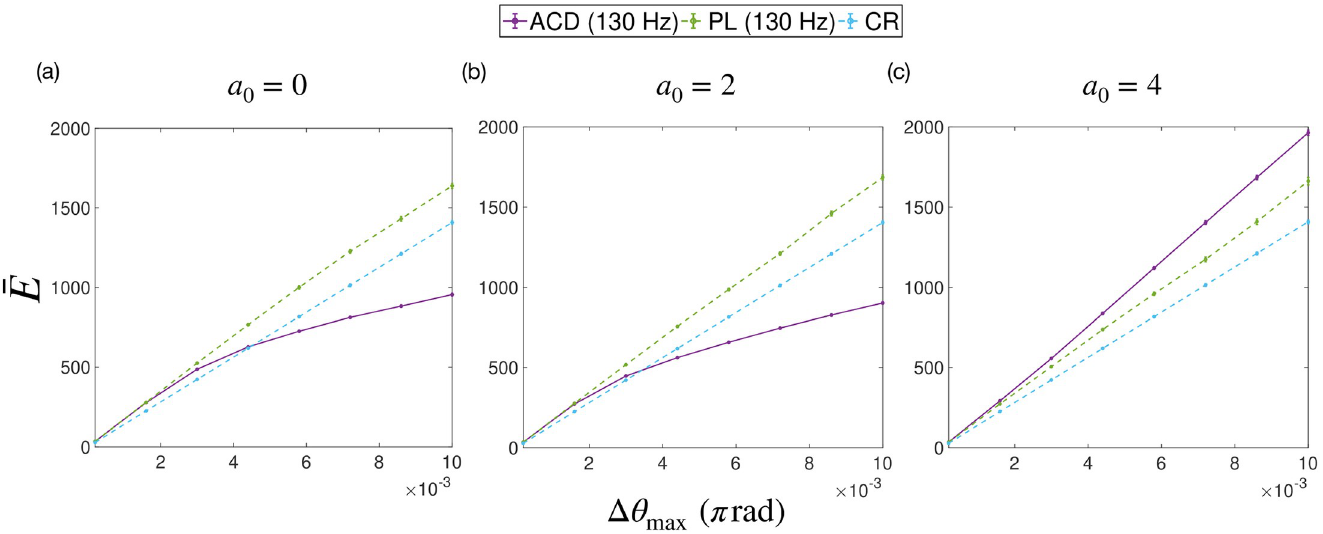
Fig 8. The total energy used by different stimulation strategies, when applied to a simulated system, as a function of the stimulation intensity Δ θ max . The strategies tested were: adaptive coordinated desynchronisation (ACD), phase-locked (PL) and coordinated reset (CR). The maximum stimulation frequencies used for ACD and PL are also given in the legend. Each sub plot shows a set of simulations performed with a particular zeroth harmonic of the uPRC a 0 .